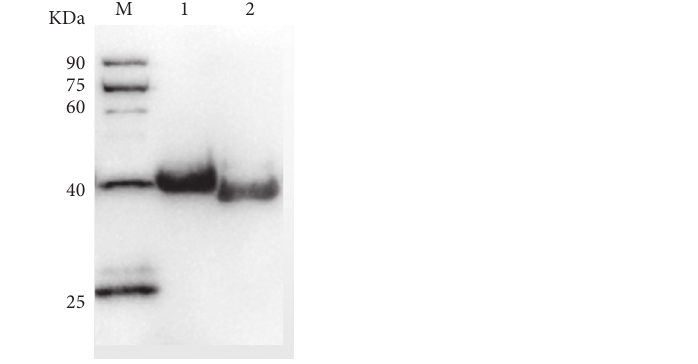
Figure 4: Western blot analysis of EXY3 and EXY4. Lane M-standard protein marker; lane 1-purified EXY 4 proteins; lane 2-purified EXY 3